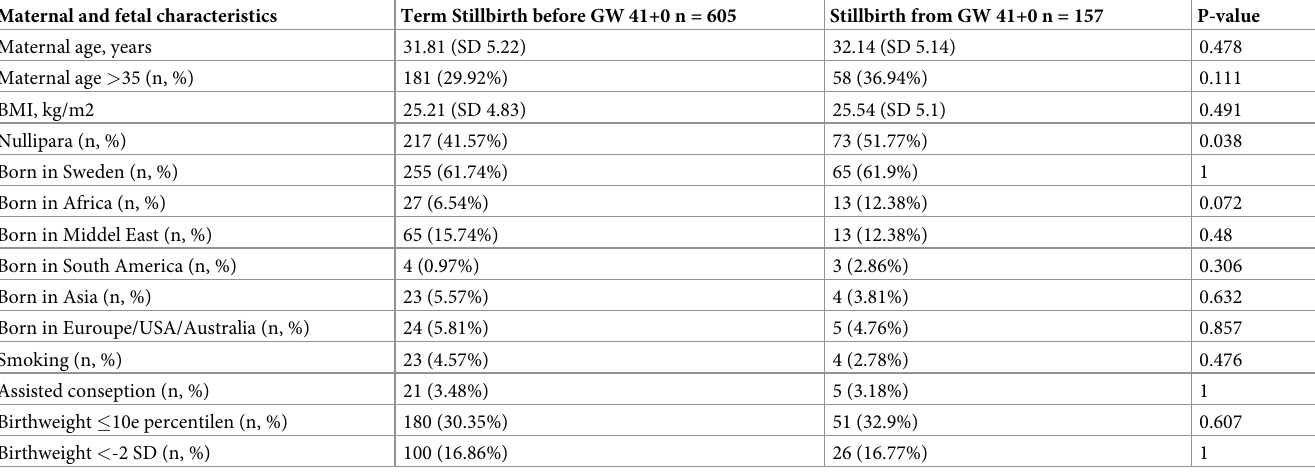
Table 2. Maternal and fetal characteristics comparing term stillbirths at GW 37+0-40+6 with term stillbirths at GW 41+0 and onwards. Maternal and fetal